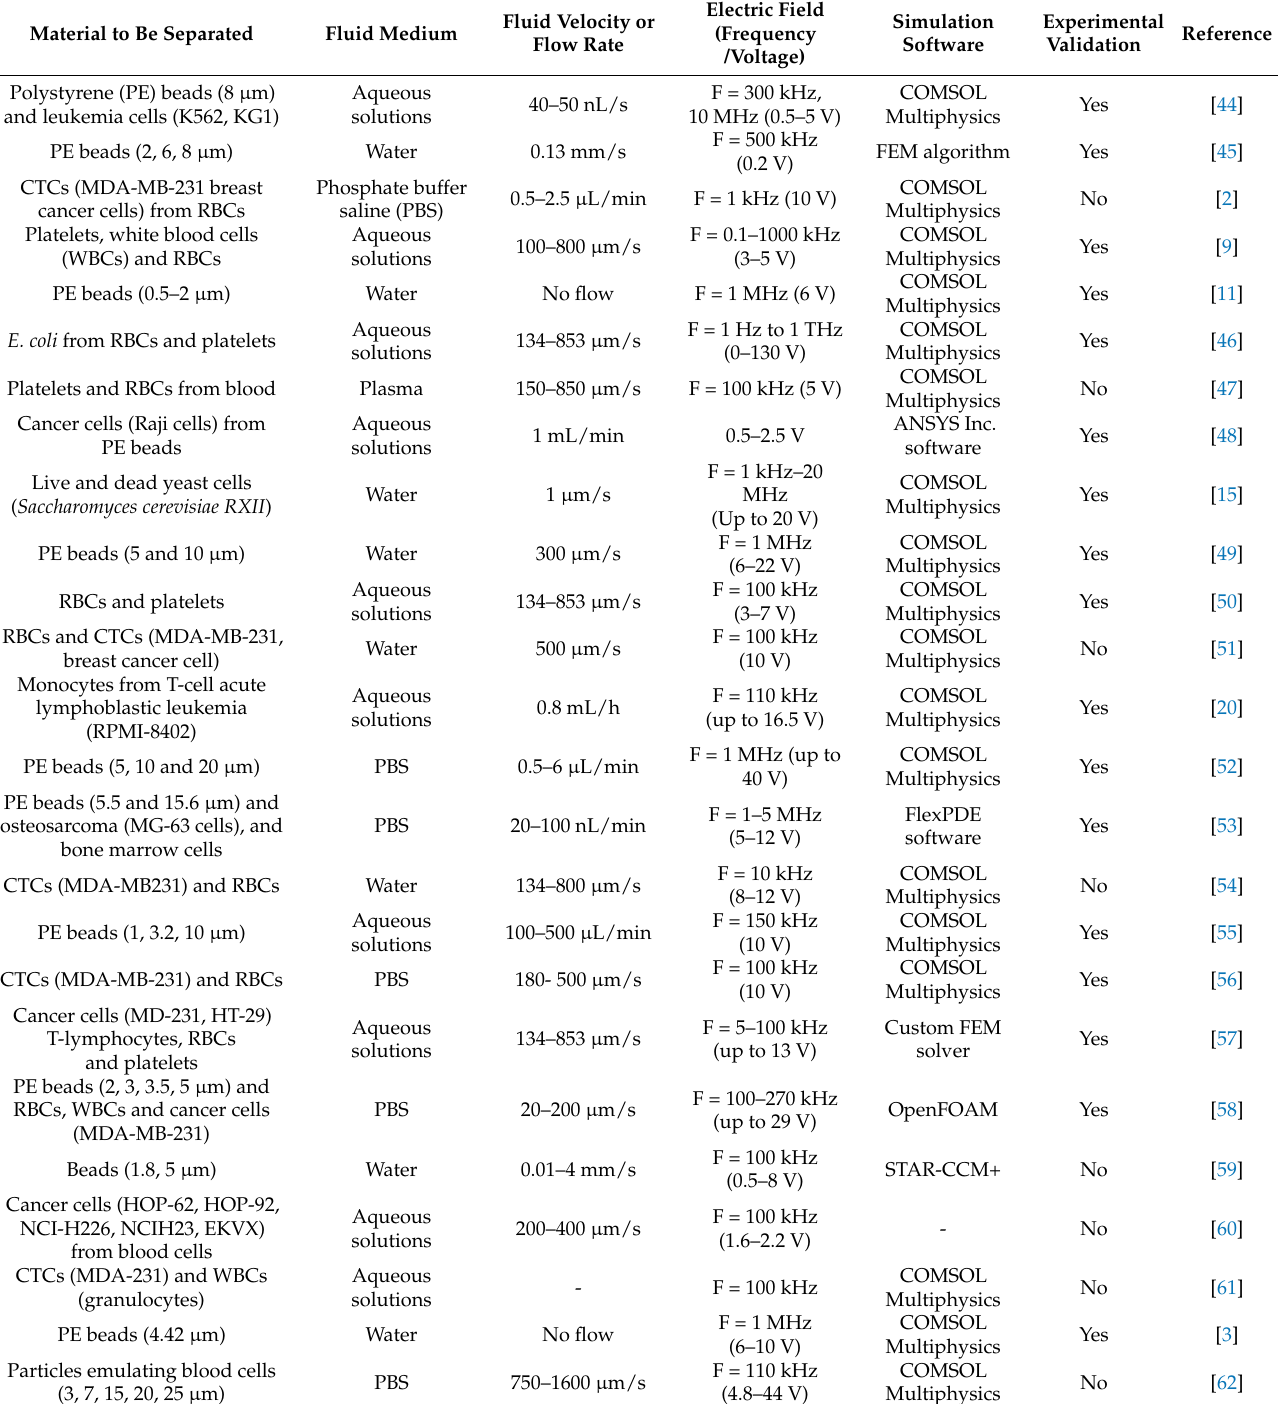
Table 2. Simulation studies dealing with particle and cell dielectrophoresis in